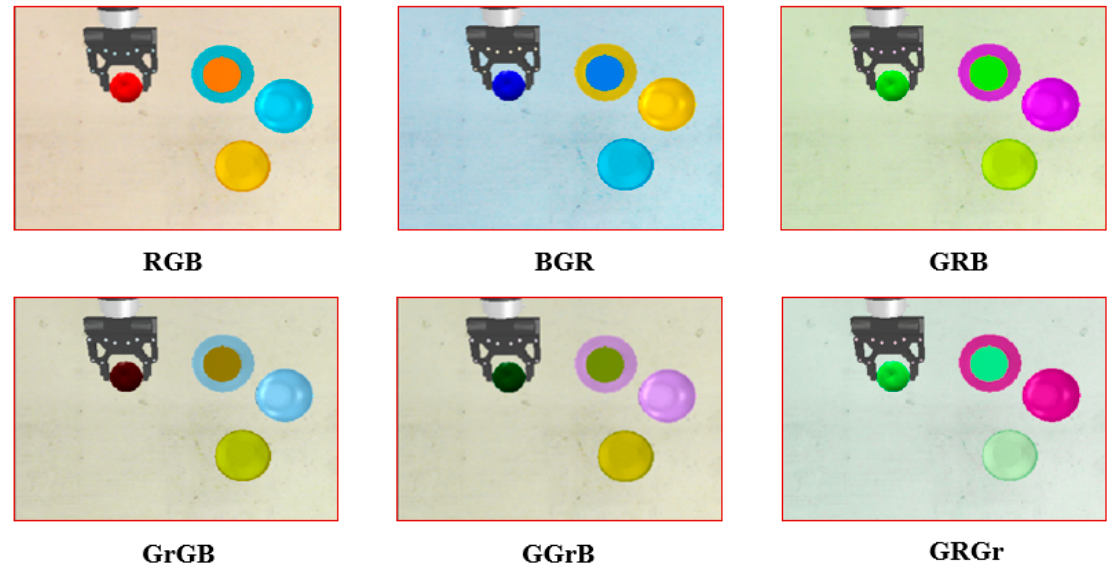
Figure 7. Augmented images with different channels.